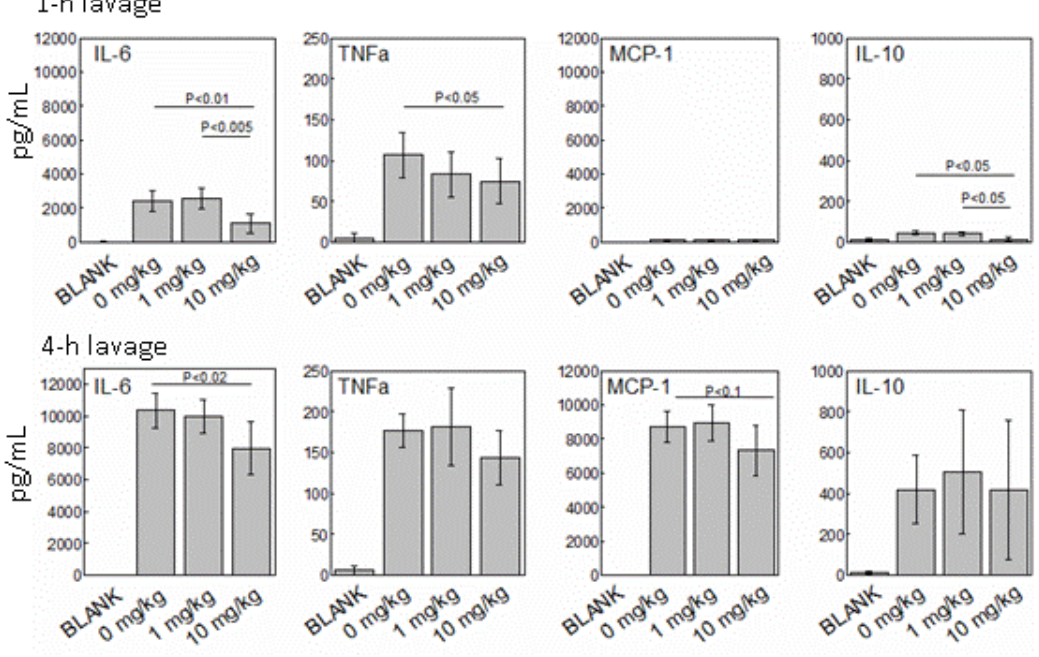
FIGURE 2 . Levels of inflammatory cytokines in the murine-inflamed peritoneum. Lavages from the peritoneum of mice were analyzed by FACSArray bioanalyzer using a murine inflammation CBA kit for the detection of IL-6, TNFα, MCP-1, and IL- 10. Mice were injected i.p with 200 μL of saline adjusted for whole body weight to deliver 0, 1, or 10 mg/kg of DOF followed 10 min later with 300 μL of 10% BTG. Lavages were performed with 5 mL PBS at 1 h (top row) or 4 h (bottom row). BLANK refers to naïve mice that received no injections. Data represent the mean ± 95% CI of five mice. Comparisons are only made for mice injected i.p. with BTG where cytokine levels were all significantly different from naïve mice, with the exception of IL-10 at 1 h for mice given DOF at 10